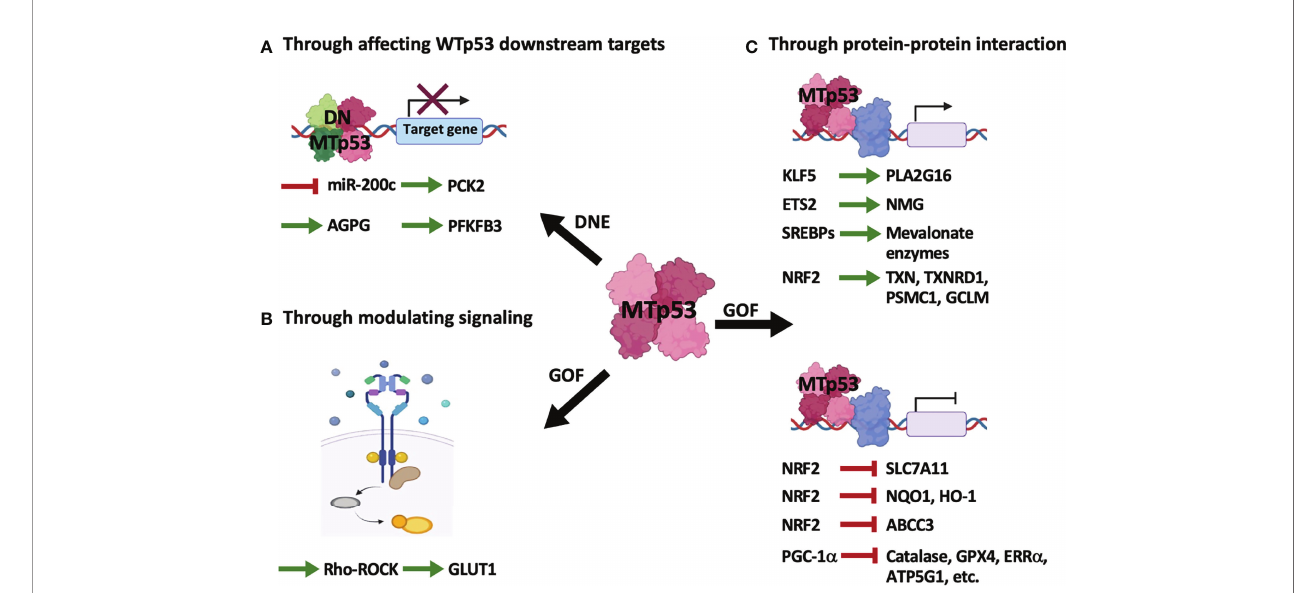
FIGURE 2 | Mutant p53 regulates cellular metabolism through indirect mechanisms. MTp53 indirectly regulates metabolism by its dominant-negative effect (DNE) over WTp53 (A) , and the gain-of-function (GOF) properties encompassing modulation of signaling pathways (B) or interaction with other transcription factors (C)